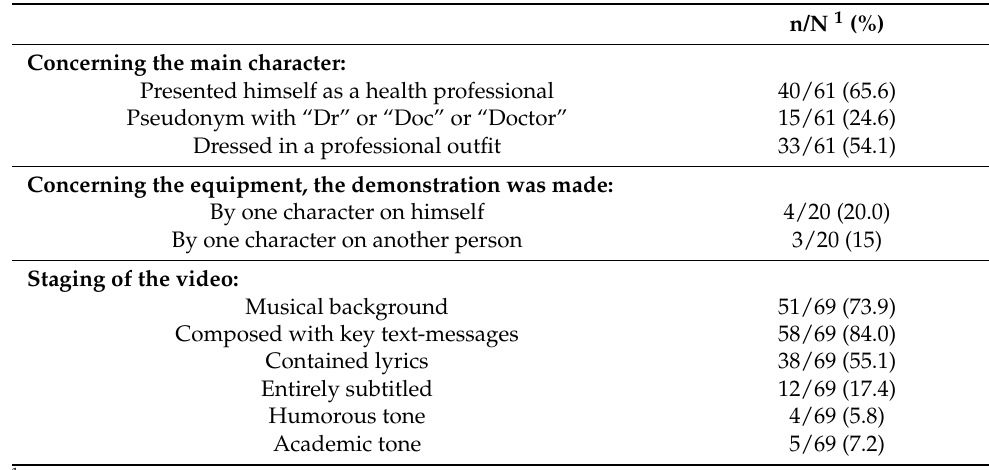
Table 1. Setting and staging characteristics of TikTok videos corresponding to #oralhealtheducation.